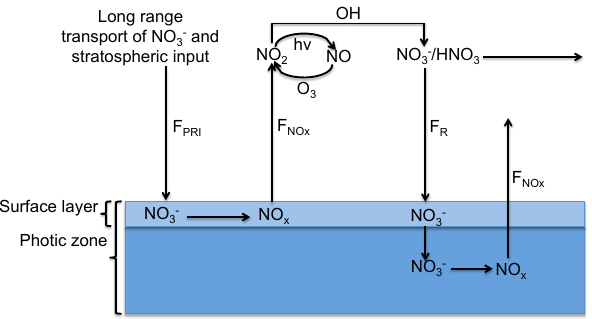
Figure 1. Schematic showing the nitrogen recycling associated with NO − photolysis as included in the model. F PRI (ng Nm − 2 yr − 1 ) is 3 the downward, primary flux of NO − to Antarctica and Greenland 3 originating from long-range transport and the stratosphere, F NO x (ng Nm − 2 yr − 1 ) is the upward flux of snow-sourced NO x to the boundary layer, and F R (ng Nm − 2 yr − 1 ) is downward, recycled flux of HNO 3 to the snow surface. The surface snow layer (top 2cm) is distinguished from the rest of the photic zone because 30– 65% of snow-sourced NO x is produced in the top 2cm of snow- pack (Zatko et al., 2013), and because both NO − concentrations 3 and actinic flux are much higher in the top surface layer compared to deeper